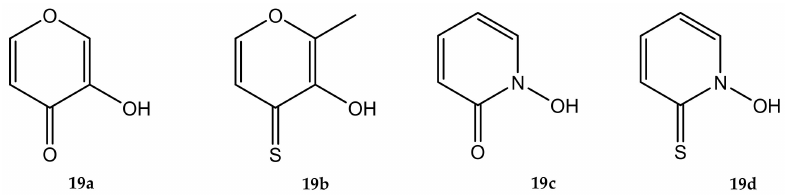
Figure 19. ZBGs of both MMPs and carbonic anhydrases (CAs)